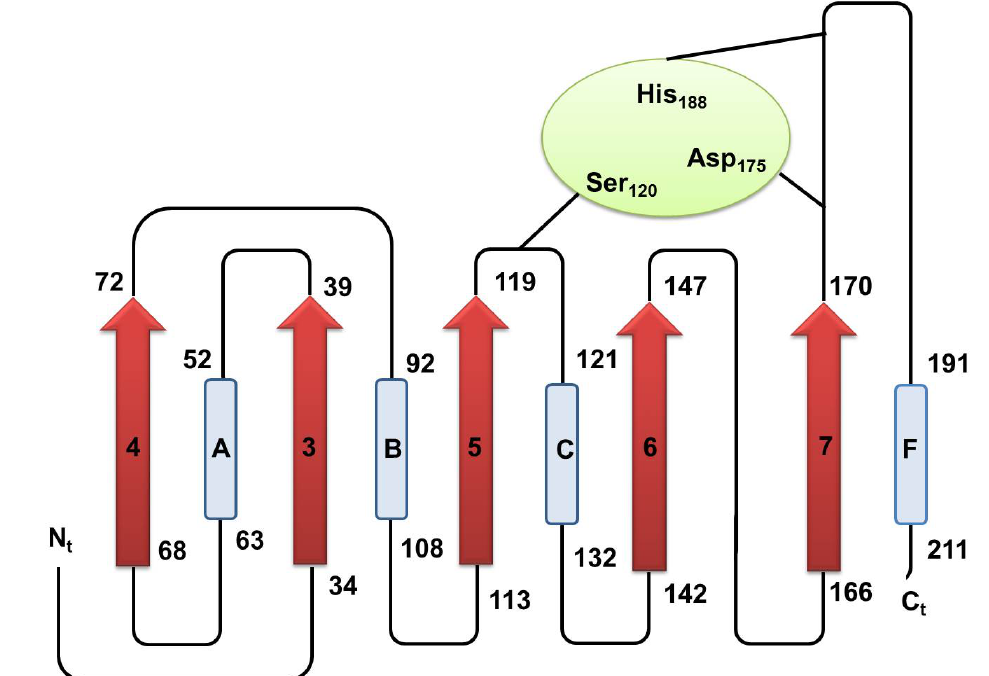
Figure 1. Diagram representing the folding of the cutinases. Five β chains (enumerated from 3 to 7) and four α helices (A, B, C, F) are shown. Near the C-terminal end is the active site formed by the catalytic triad Ser 120 , Asp 175 and His 188